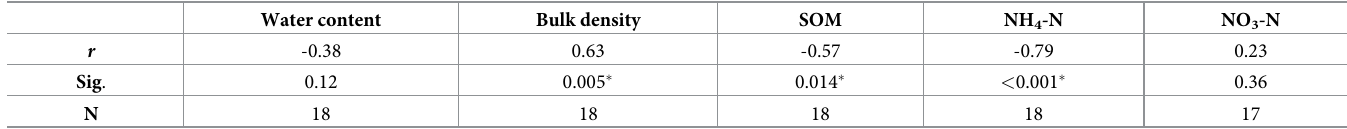
Table 2. Correlation between N 2 O flux and soil properties. The asterisks indicate significant correlation at p < 0.05 based on the Spearman’s Correlation Analysis, r . Water content